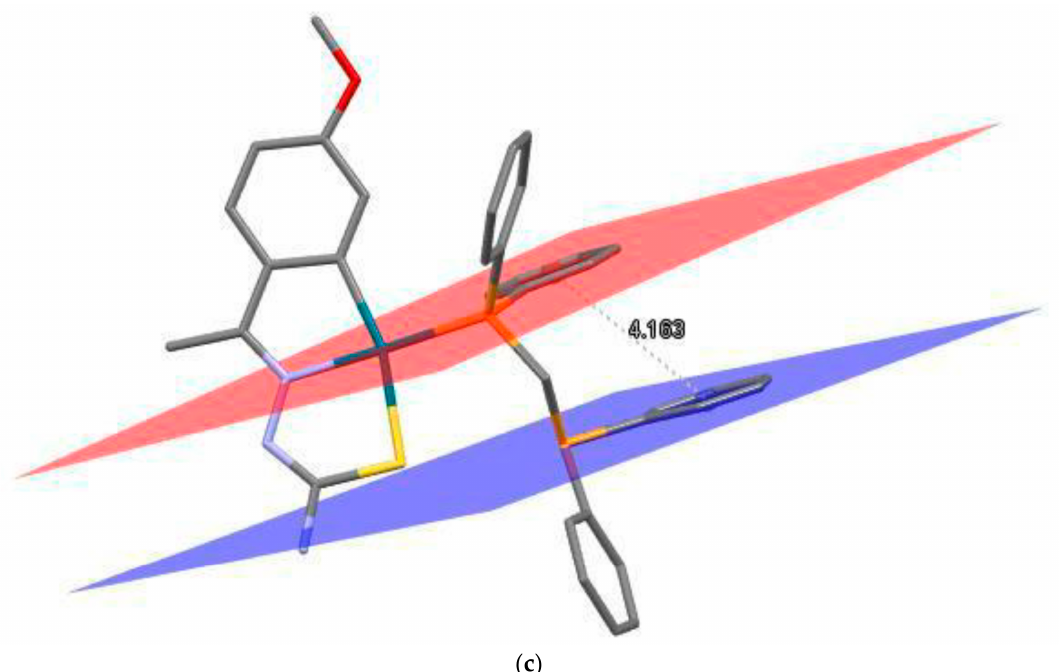
Figure 4. ( a ) Molecular structure of compound 1b . Hydrogen atoms have been omitted for clarity. ( b ) Bond distances (Å) and angles (°) around the palladium center. ( c ) Intramolecular π – π stacking interaction in 1c .